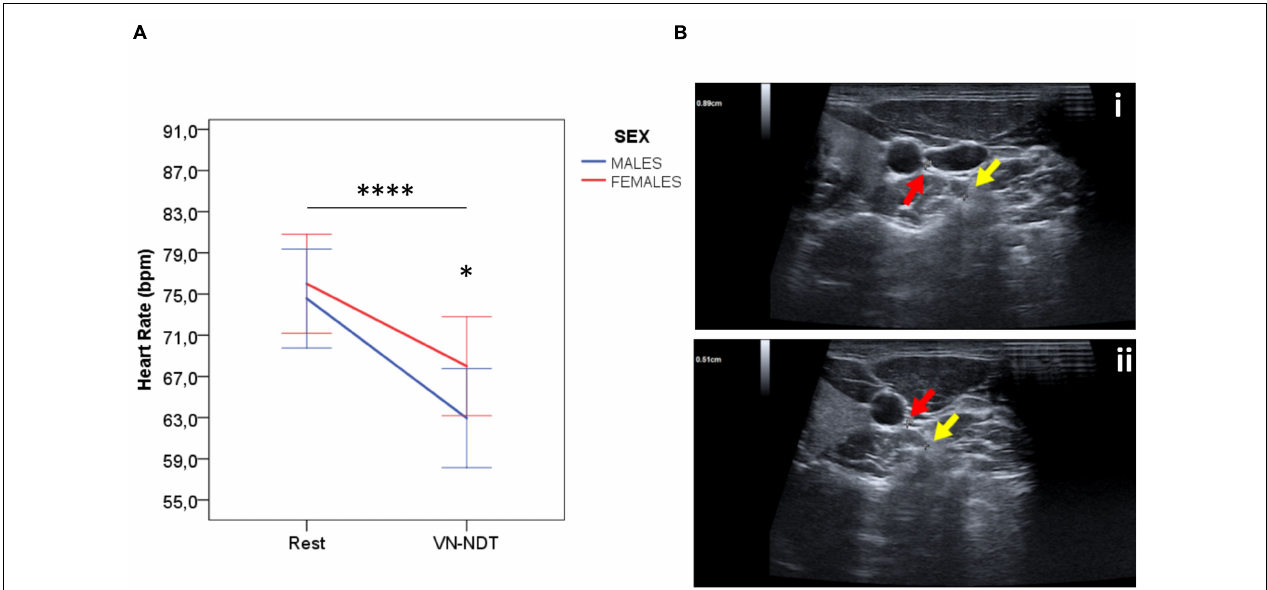
FIGURE 3 | (A) Effect of the VN-NDT on HR in males and females. Values in the graph are expressed as mean ± SD. Two-way ANOVA was carried out (data are normally distributed with comparable variances); asterisk shows the statistically significant difference between sexes (* p ≤ 0.05 and **** p ≤ 0.0001). (B) Ultrasound imaging axial scans of the (i) right vagus nerve at rest and (ii) the final position of the neurodynamic test. The red arrow indicates the vagus nerve and the yellow arrow indicates the anterior tubercle of C6 in male or female participants (no differences between sexes were detected by USI, p = 0.54).